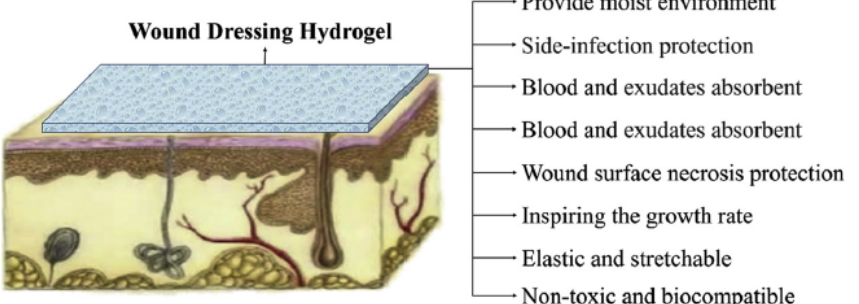
Figure 4. Schematic illustration representing the application of hydrogel materials in the wound-dressing field. Reprinted with permission from the authors of [24]. Copyright 2019 Elsevier. dressing field. Reproduced with permission from [24]. Elsevier,